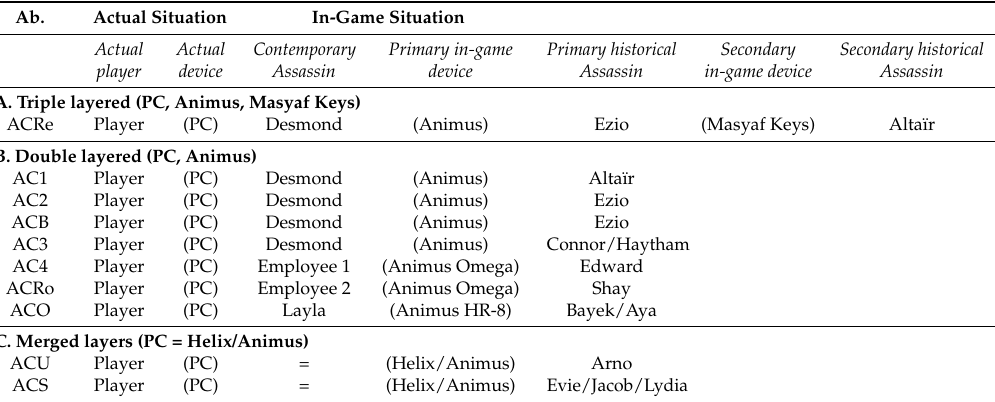
Table 2. Narratological structures. Overview of the different narratological layers in the primary games of the Assassin’s Creed series. They are listed in the order of narratological complexity (primary) and game-internal time frame